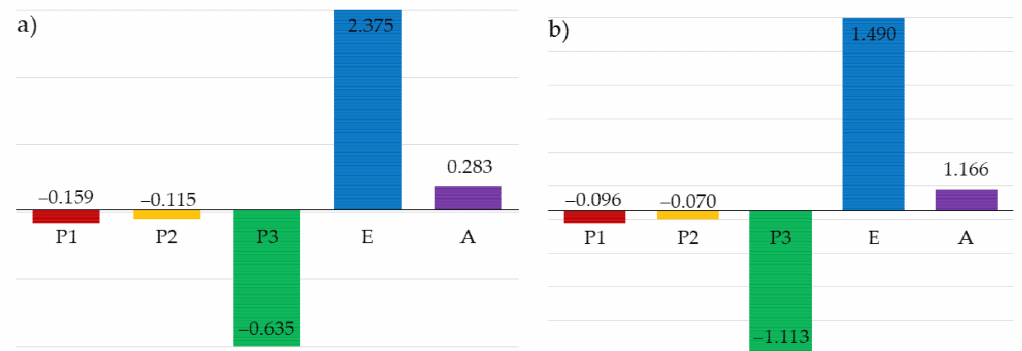
Figure 12. Elasticity index for SLS: ( a ) Case 1, ( b ) Case